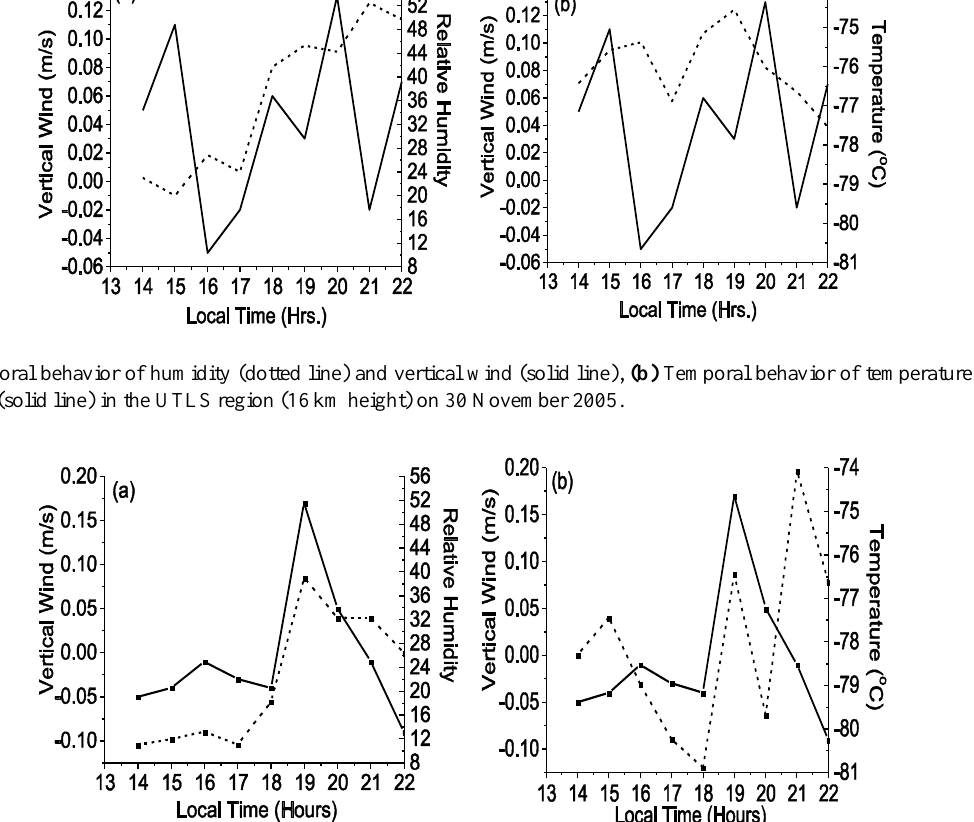
4 on 30 November vs. 9.8 on 9 December 2005, indicates a deeper and stronger convective event on 9 December